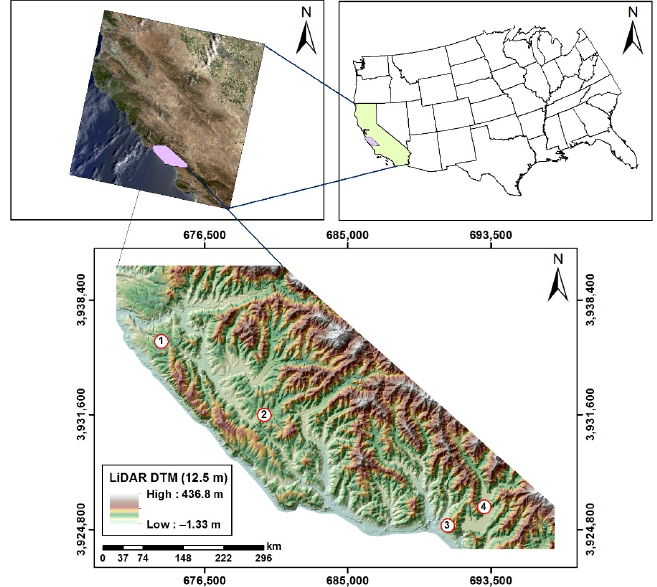
Figure 1. The study area in San Luis Obispo County, the western part of the central coast of California, USA. (1–4) refer to Cambria, Harmony, Cayucos, and Whale Reservoir, respectively. The source of the satellite imagery (top left) is ESRI, 2018